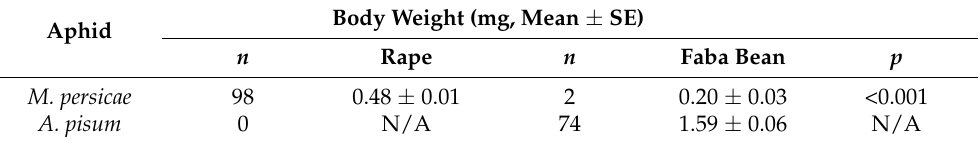
Table 3. Body weight of newly developed M. persicae and A. pisum adults reared on rape versus on Table 4. Fecundity of M. persicae and A. pisum reared on rape versus on faba bean.